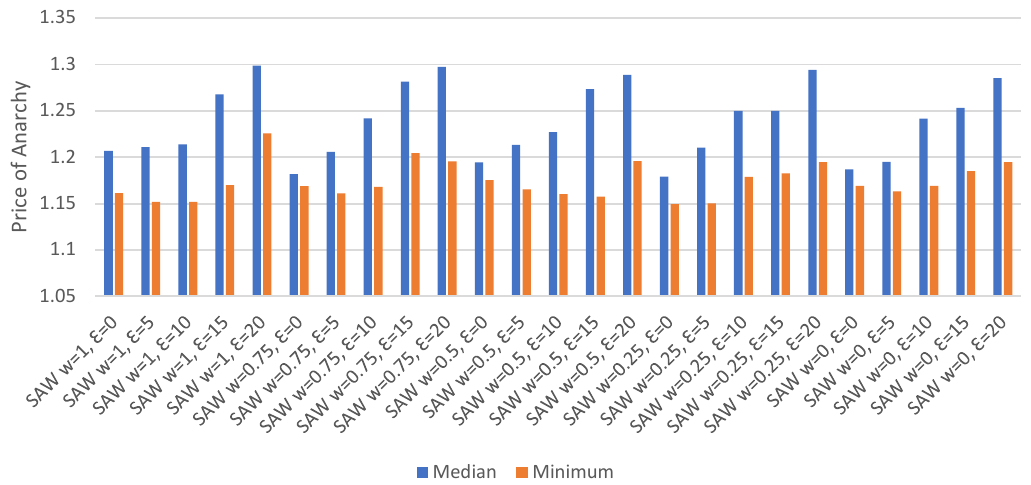
Figure 3. Minimum/median price of anarchy with direct experience, no re-routing. User Equilibrium Points. Figure 4 displays the number of occurrences of user equi- librium for each set of parameters. Equilibrium occurred only where the epsilon value was set to 0 as the agents would randomly select alternative routes when using higher epsilon values, regardless of their perceived likelihood of producing a better route time, preventing equilibrium from being achieved.